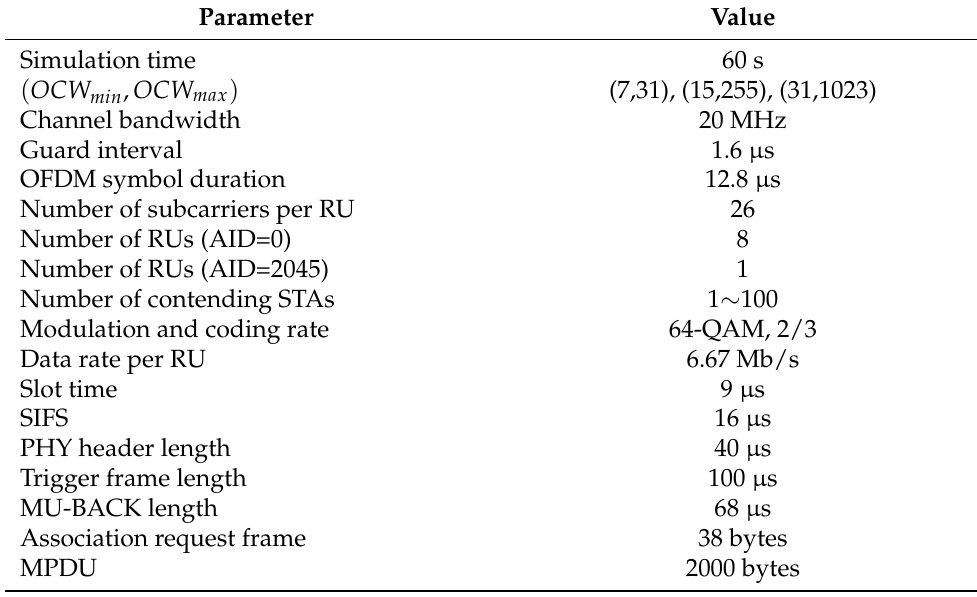
Table 1. Simulation